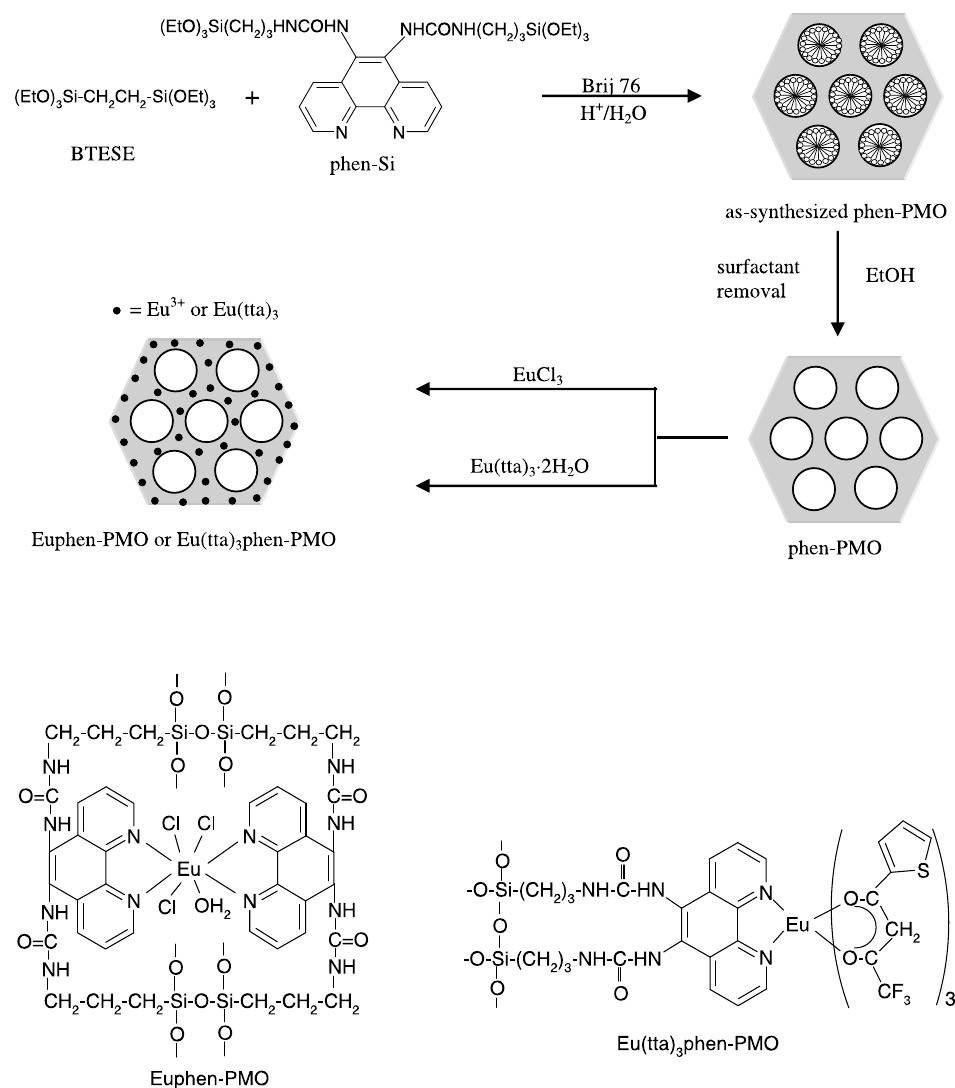
Figure 5. Schematic representation of the co-condensation of 1,2-bis(triethoxysilyl)ethane and 5,6-bis(N-3-(triethoxysilyl)propyl)ureyl-1,10-phenantroline to form a novel PMO material and its post-functionalization with an europium complex [39].